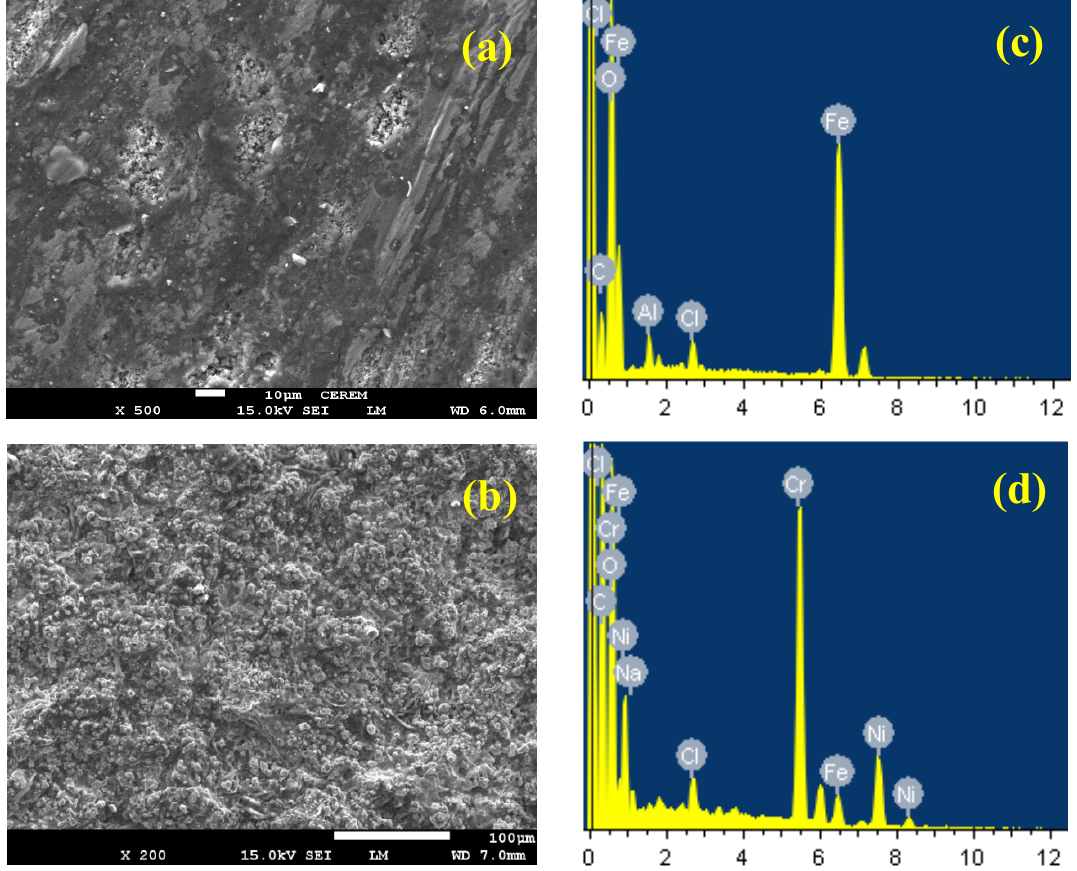
Figure 14. ( a , b ) the SEM images and ( c , d ), the corresponding EDX spectra for API-2H steel and 75%Cr 3 C 2 − 25%NiCr coated API-2H steel, respectively, after their immersions for 48 h in NaCl solutions before stepping a value of − 0.7 V for 40 min.